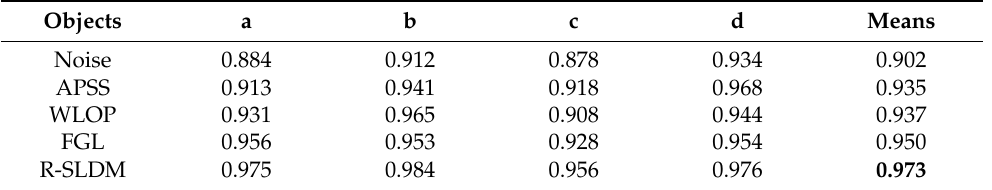
Table 6. SSIM of different denoising algorithms for four